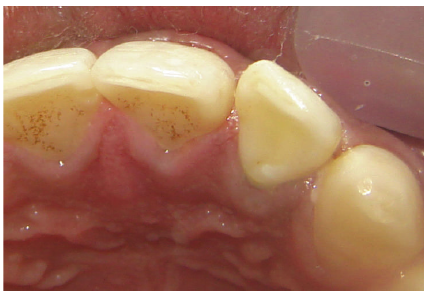
Figure 10: Palatal view after two and half years (mirror image).